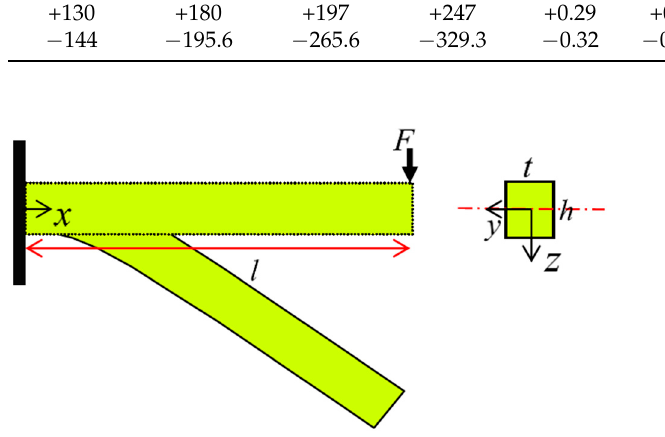
Figure 16. The cantilever (half of the three-point bending model) beam subjected to transverse loading at free end.